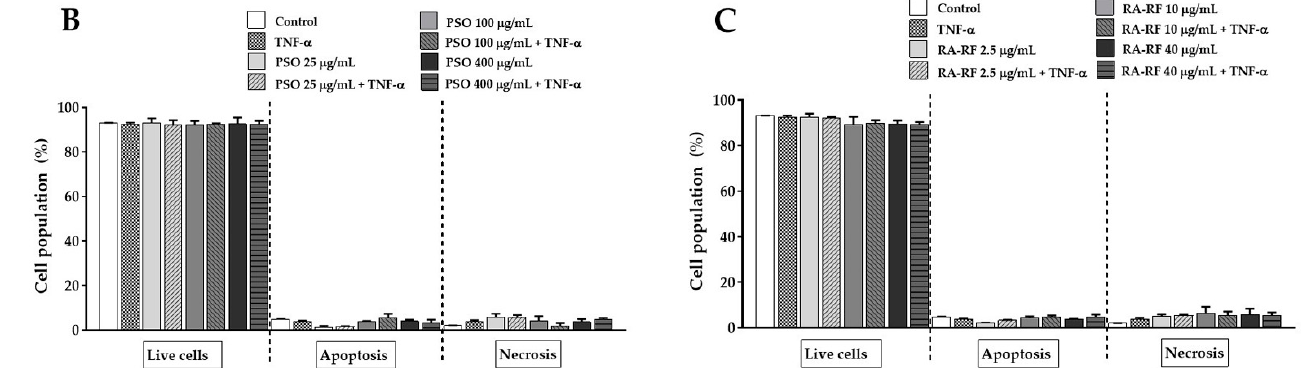
Figure 3. Cell apoptosis and necrosis of A549 cells upon the treatment of PSO (25, 100, and 400 µg/mL) or RA-RF (2.5, 10 and 40 µg/mL), followed by treatment with or without 100 ng/mL TNF- α . Cells were then analyzed using flow cytometry. Dot plots show annexin V-FITC+/PI- as early apoptotic cells, annexin V-FITC+/PI+ as late apoptotic cells, and annexin V- FITC-/PI+ as necrotic cells ( A ). Live, apoptotic, and necrotic cells were presented as a percentage of cell population in the bar graphs of PSO ( B ) and RA-RF ( C ). The data were reported as a mean ± SD of three independent experiments carried out in triplicate.